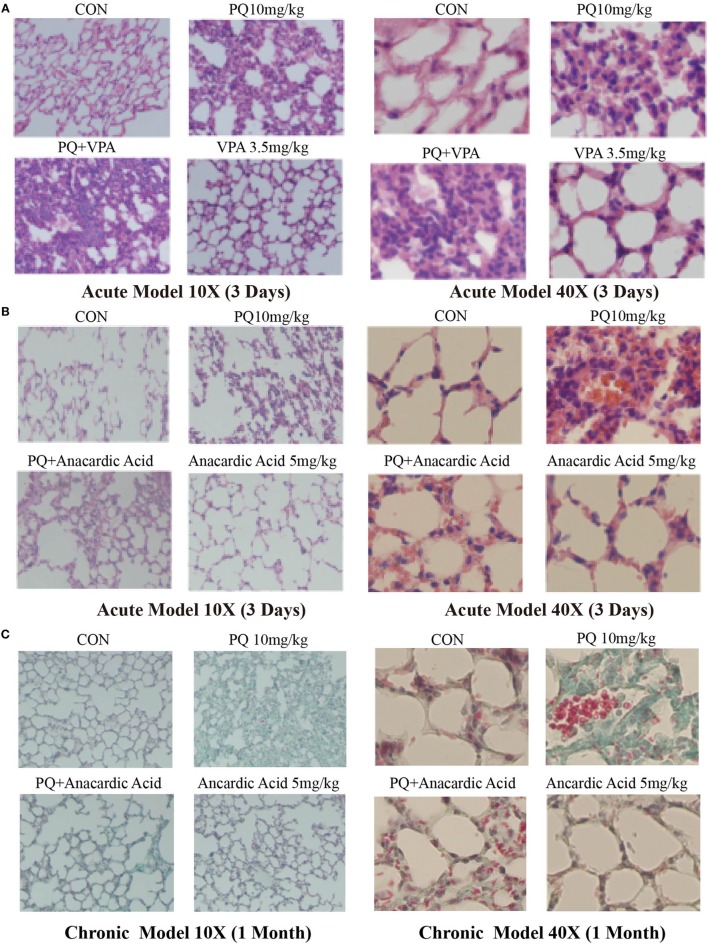
Changes in pulmonary acute inflammation, pulmonary fibrosis following paraquat (PQ) exposure in mice treated with histone deacetylase or histone acetyltransferase inhibitors. Wild-type C57BL/6 male mice were treated with vehicle (saline) or 10 mg/kg of PQ for 3 days, and mice received VPA (3.5 mg/kg) or anacardic acid (5 mg/kg) starting 24 and 1 h before PQ injection. (A,B) Lung sections from day 3 mice were stained with hematoxylin and eosin staining for visualization of inflammatory cell infiltration. Wild-type C57BL/6 male mice were treated with vehicle (saline) or 10 mg/kg of PQ for1 month, and mice received anacardic acid (5 mg/kg) starting 1 h before PQ injection, 24 h and 15 days after PQ injection. (C) Lung sections from day 30 mice were stained with Masson’s trichrome for visualization of collagen deposition (green). (D)
COL1-α immunofluorescence (red) in lung sections. Sections are representative of n = 4–6 mice from each group.